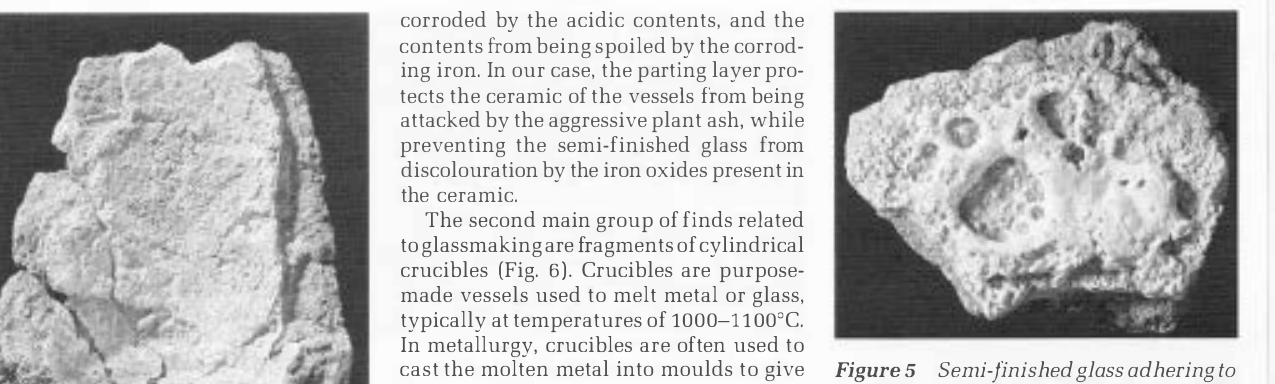
Figure 5 Semi-finished glass adhering to a fragment of a reaction vessel.